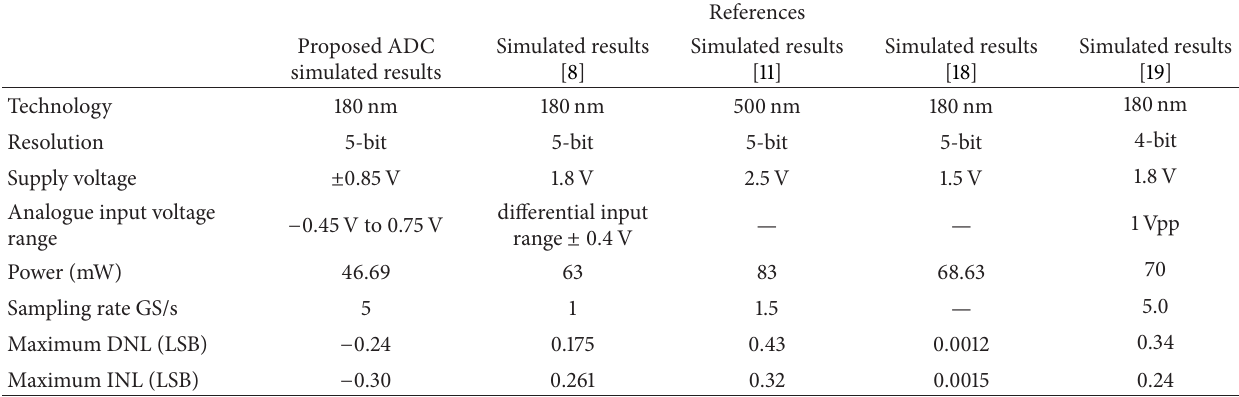
Table 5: Comparative performance analysis of candidate